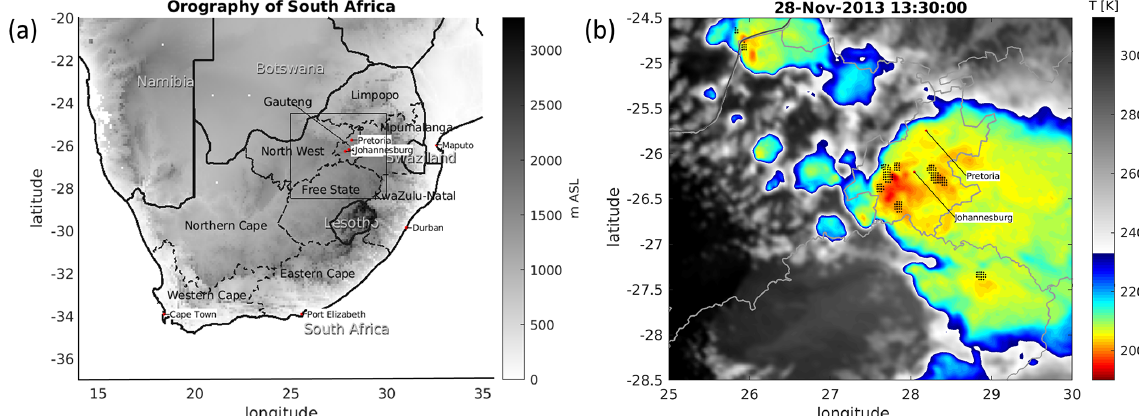
Figure 2. (a) Map showing the relief of South Africa from the Shuttle Radar Topography Mission (Farr et al., 2007), provinces, and major cities. Port Elizabeth and Swaziland are now Gqeberha and Eswatini, respectively. (b) Meteosat IR image showing convective storm activity on 28 November 2013 at 13:30UTC. Colors represent 10.8µm channel brightness temperature, and dots indicate detected overshooting tops (OTs, black) for this image. OT detections are parallax-corrected here but the underlying IR satellite image is not, leading to some slight displacement of a detection and a corresponding cold region. The anvil cloud in yellow and green colors is automatically detected using the IR anvil detection index greater than